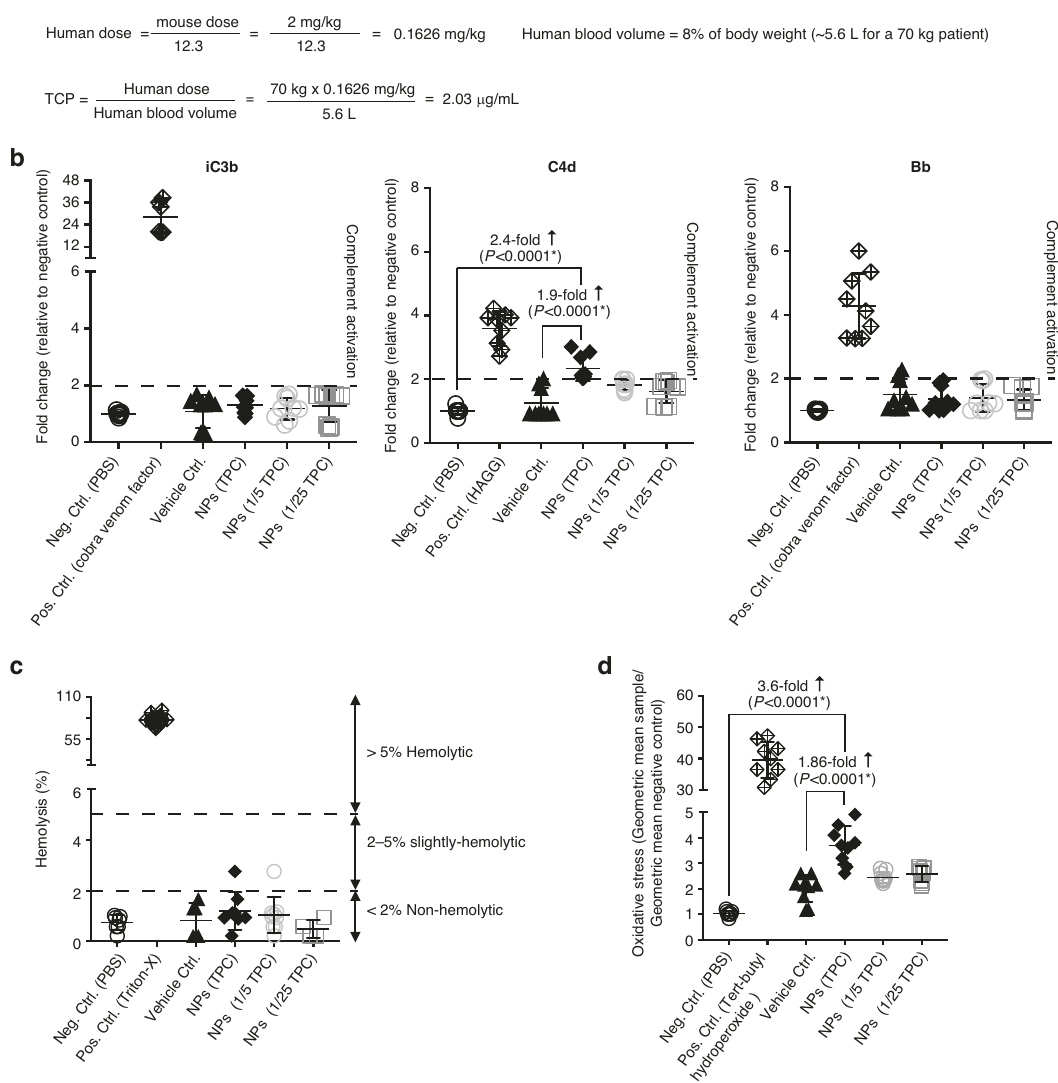
Fig. 9 In vitro analysis of possible infusion reactions. a Calculation of the theoretical plasma concentration. b Hemolytic activity of T-cell-targeted mRNA nanoparticles (NPs). c Quantitative determination of complement activation by an Enzyme Immunoassay. A 2-fold change relative to the negative PBS control was de fi ned as the assay threshold (dashed line). d Mitochondrial oxidative stress in lymphocytes following NP transfection. In all panels of this fi gure, N = 9 biologically independent blood samples were analyzed. Also shown are the mean values ± SD. Pairwise differences between groups were analyzed by two tailed unpaired Student ’ s t